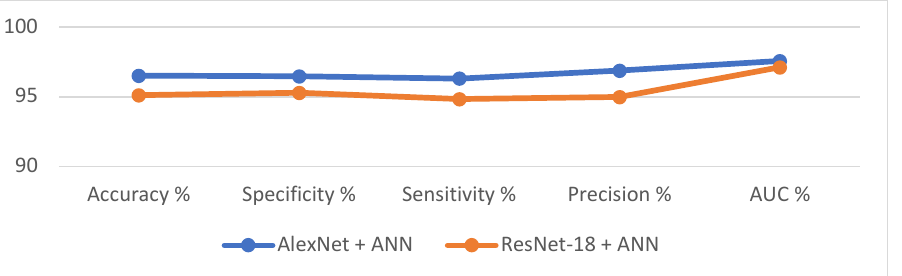
Figure 14. Display of ANN performance based on the features of AlexNet and ResNet-18 models.